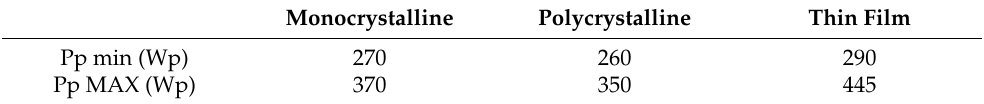
Table 6. Maximum and minimum peak power of the considered sample; PVsyst validation.